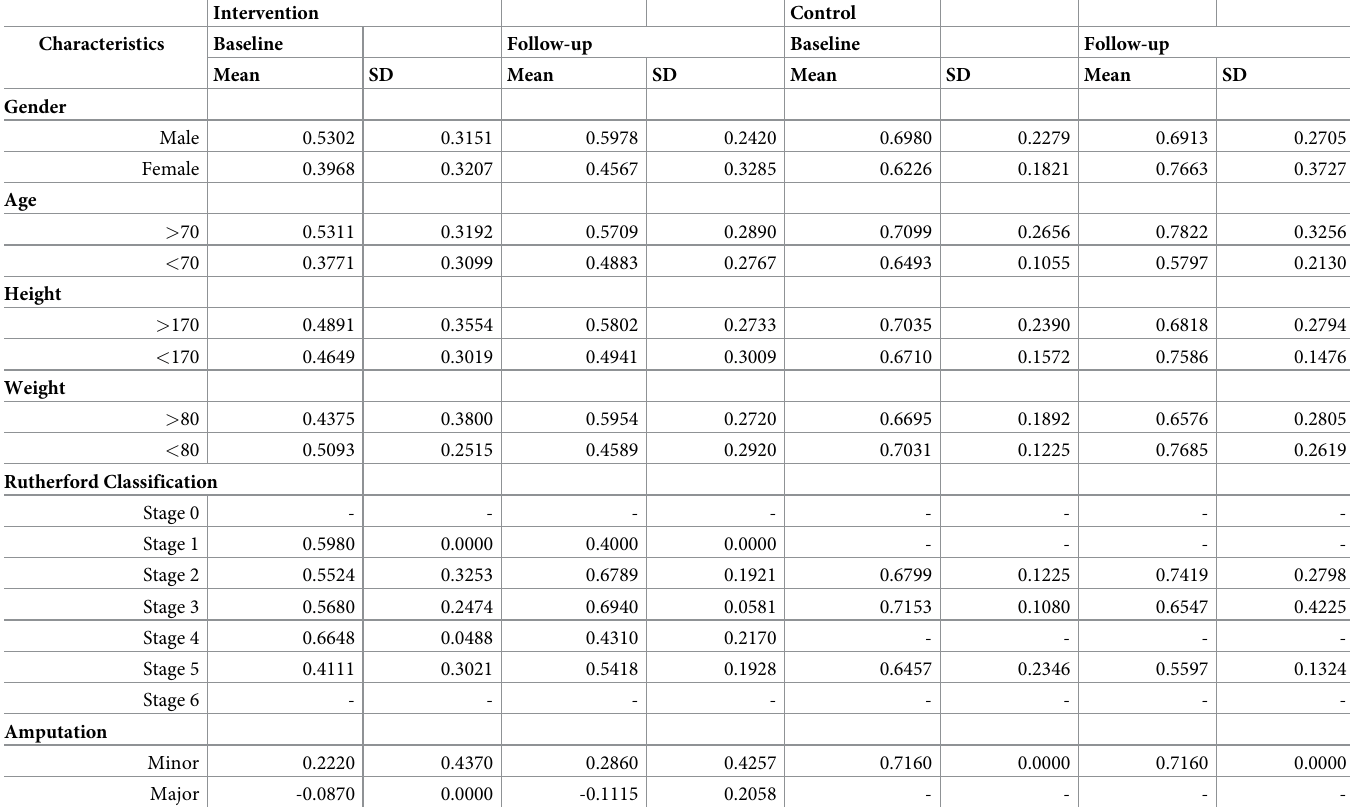
Table 5. Baseline heterogeneity in health-related QoL (i.e.